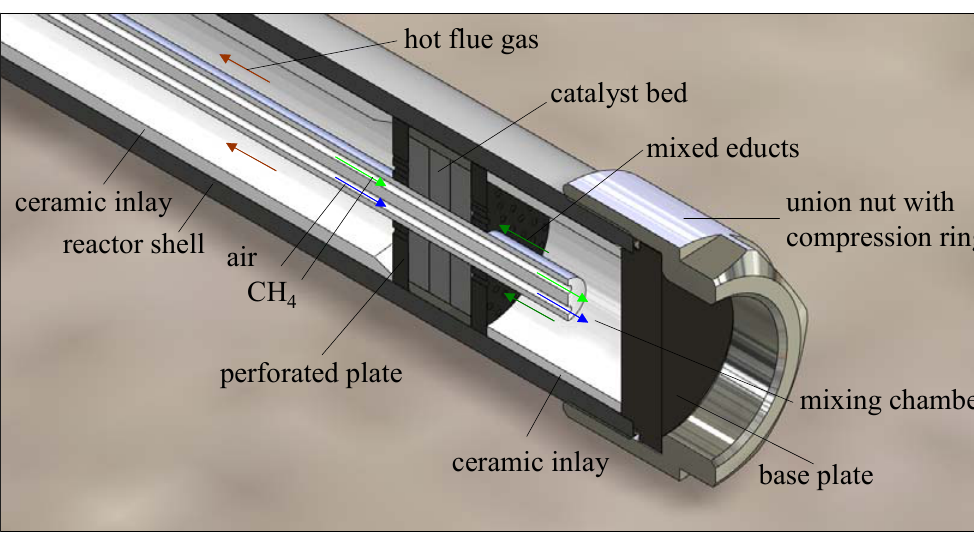
Figure 7. Technical sketch of the countercurrent heat exchange reactor